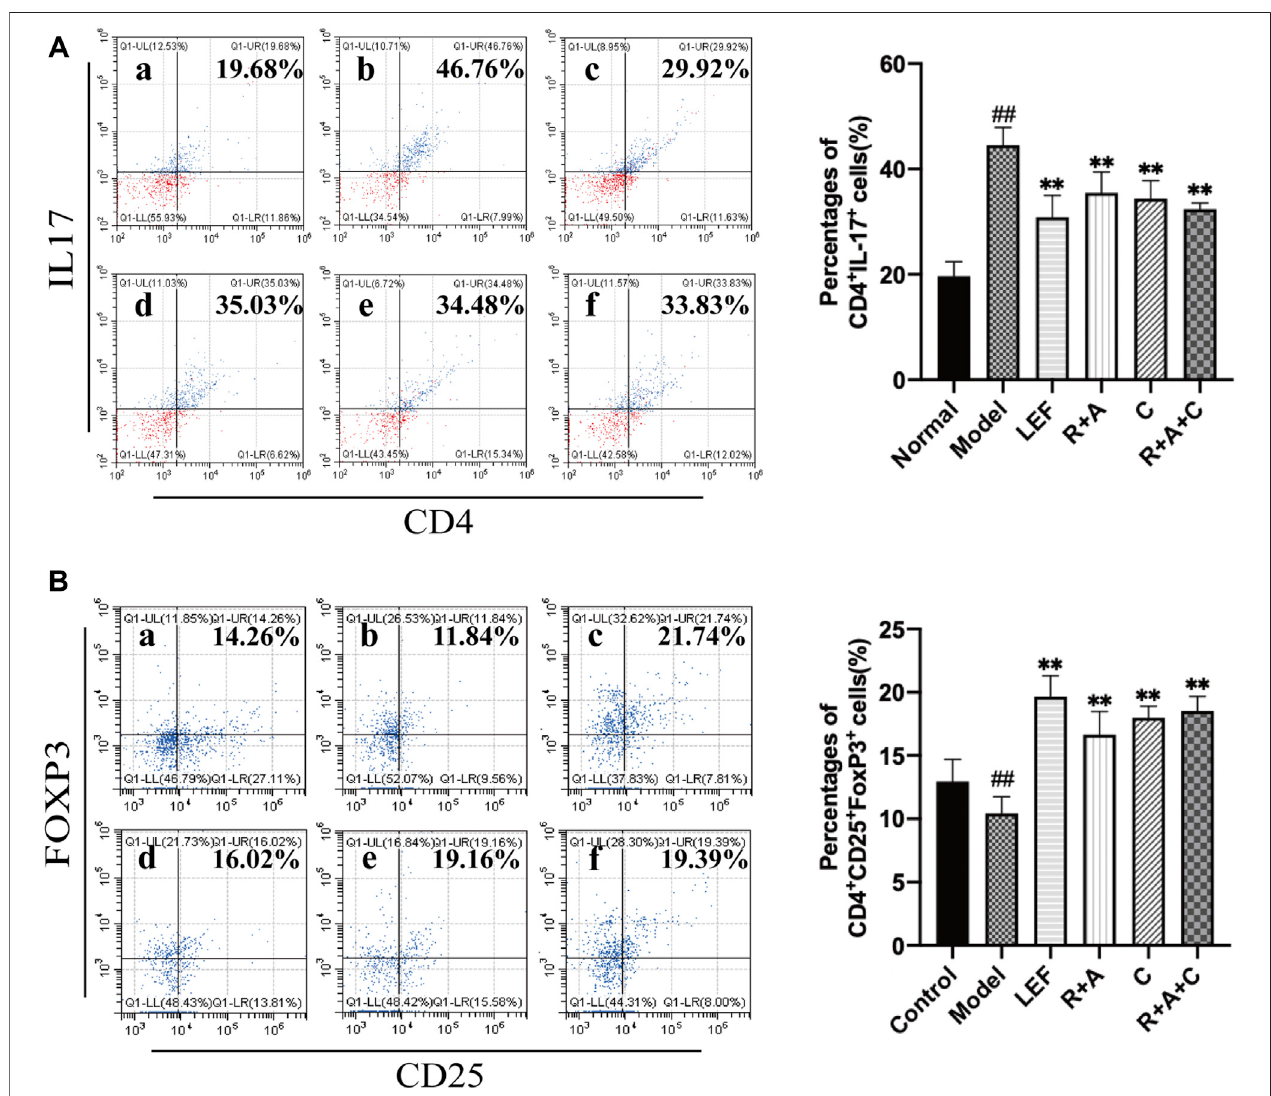
FIGURE 5 | The percentages of Th17 and Treg cells. (A) The percentages of CD4 + IL-17 + T-cells. (B) The percentages of CD4 + CD25 + FOXP3 + T-cells. (a) , control group; (b) ,modelgroup; (c) ,LEFgroup; (d) , R . astragali + R . angelicaesinensis (R+A)group; (e) , C . lonicerae (C)group;and (f) , R . astragali + R . angelicaesinensis + C . lonicerae (R + A + C) group. The results are presented in the bar charts ( n = 8). Data are presented as the mean ± SD ( n = 8); # p < 0.05, ## p < 0.01, compared with the normal group; * p < 0.05, ** p < 0.01, compared with the model group.